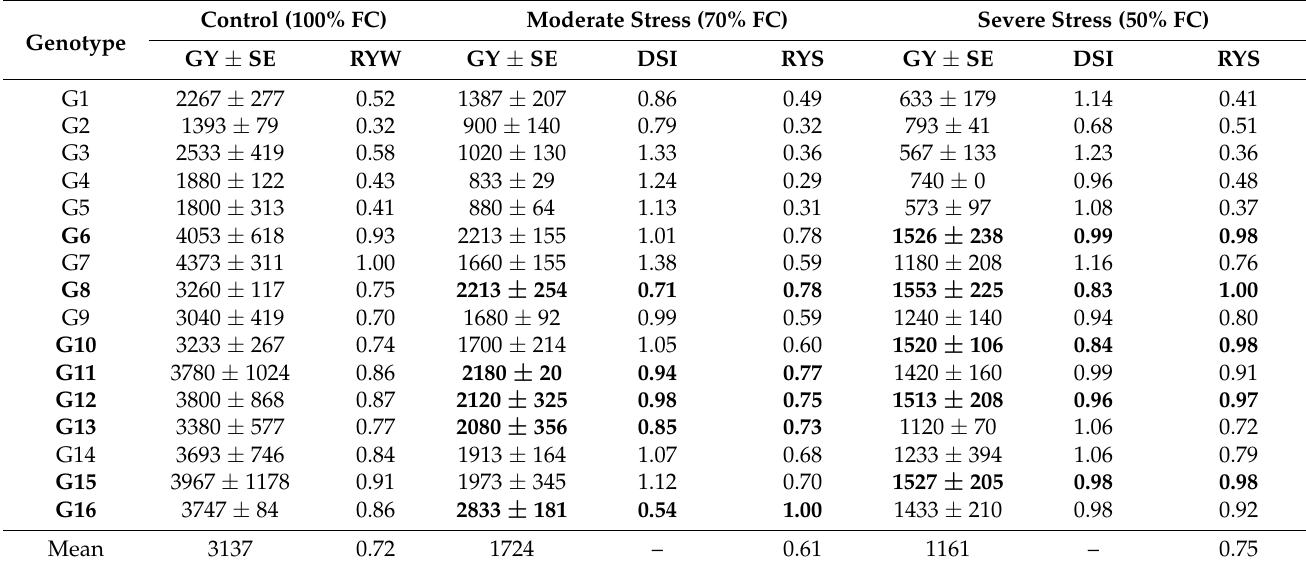
Table 1. Drought susceptibility index and relative yield of sixteen upland rice genotypes under the control, moderate stress, and severe stressed